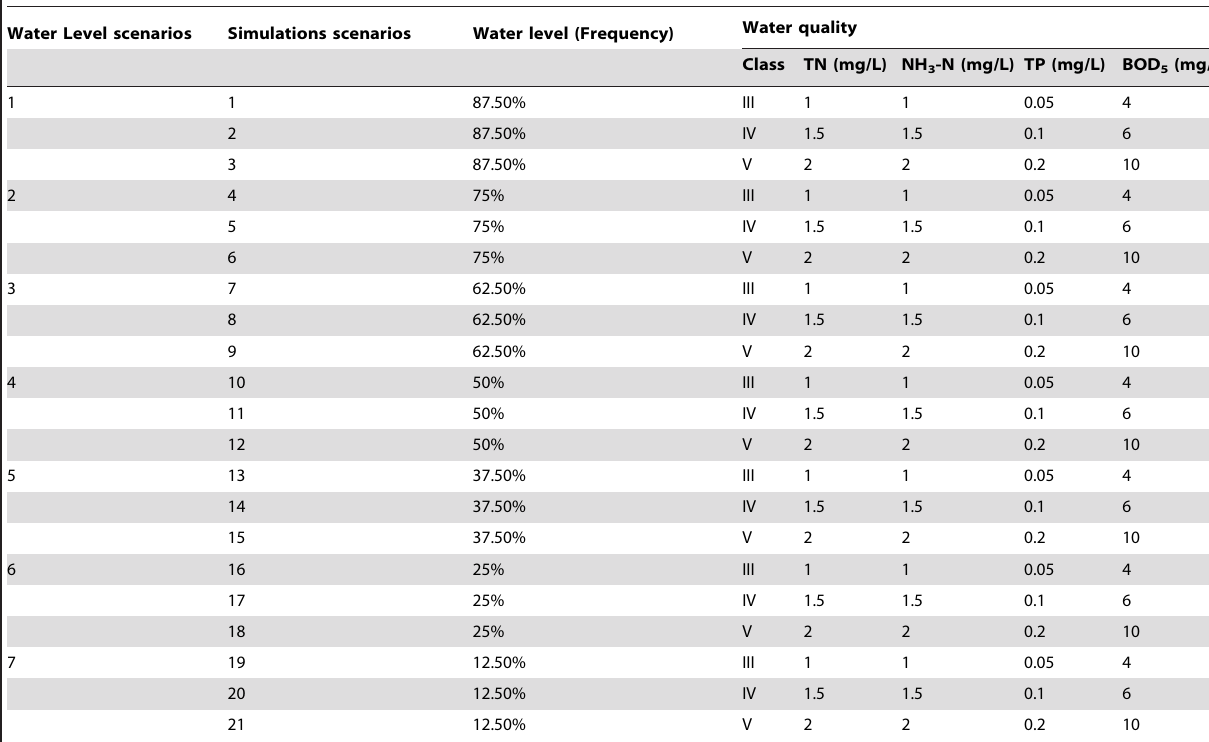
Table 1. Water level and simulation scenarios.